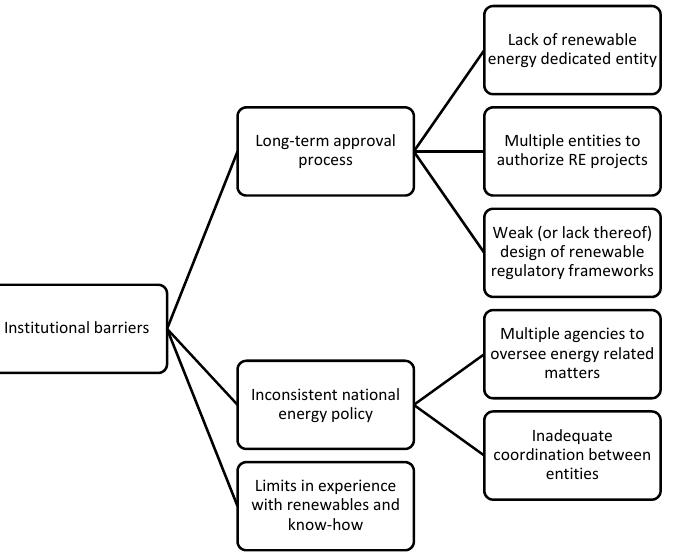
Figure 2. Institutional barriers for renewable energy adoption in the GCC. Adapted from [48].